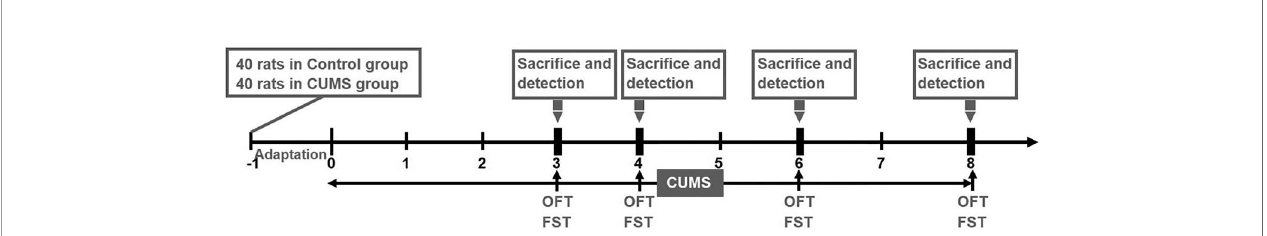
FIGURE 1 | Experimental schedule. Prior to the experiment, a total of 80 rats (n = 40 in control group, n = 40 in CUMS group) were allowed a one-week adaptation period. Rats in the CUMS group received a daily CUMS stimulation, and behavior tests including OFT and FST were performed at various time points (3, 4, 6, 8 weeks). Subsequently, 10 rats from each of the two groups were sacri fi ced to detect the levels of blood glucose, blood lipids, proteins, and genes at the above time